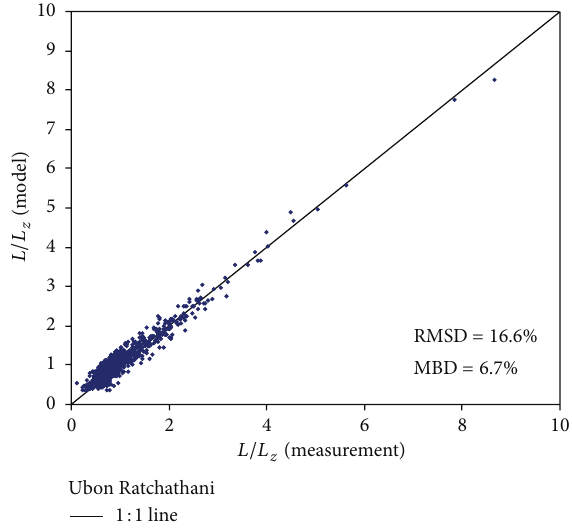
Figure 14: Comparison between the relative sky luminance cal- culated from the 𝐿/𝐿 𝑧 model and that obtained from the 𝐿/𝐿 𝑧 measurement for Ubon